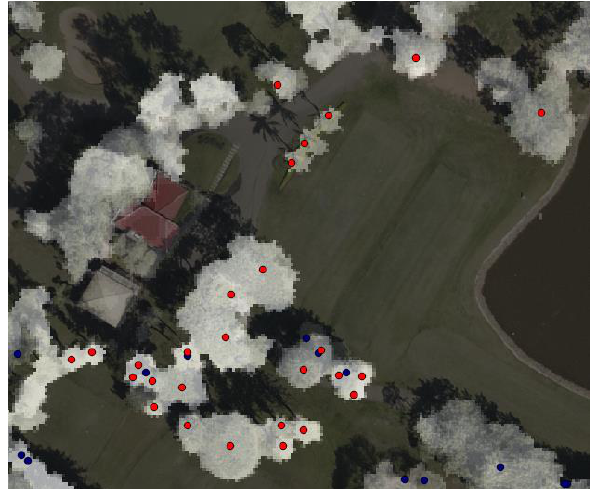
Figure 7. Extraction result by the MMAC method using the simple subtraction